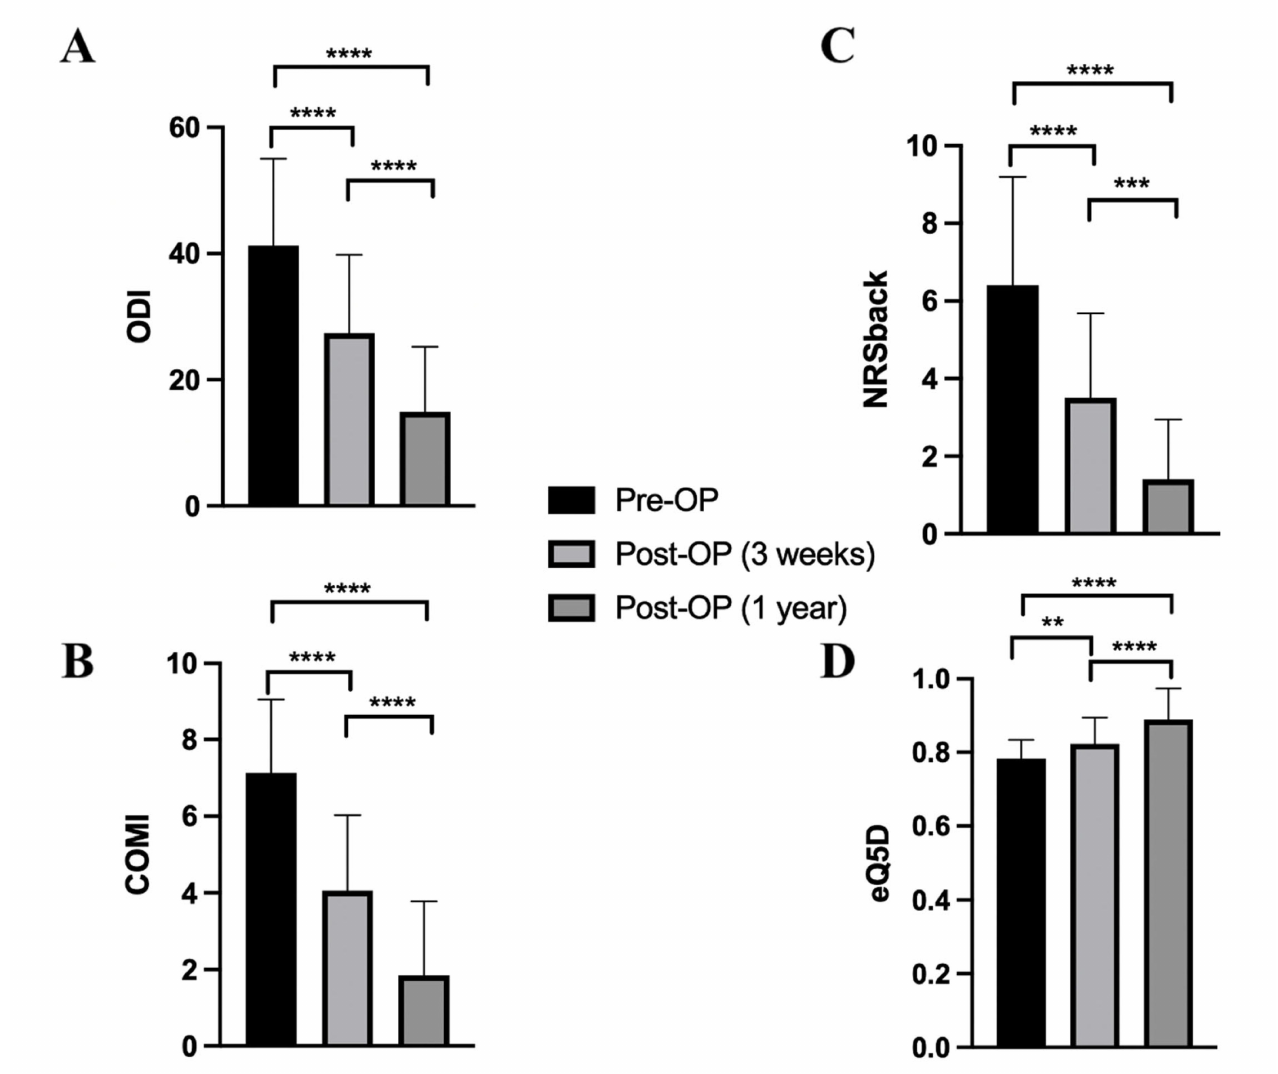
Figure 2. Bar charts show the ODI ( A ), COMI ( B ), NRS back ( C ), and eQ-5D ( D ) difference be- tween time points after thoracolumbar spine stabilization utilizing minimal-invasive percutaneous screw-rod stabilization. Pre-OP: preoperatively; Post-OP (3 weeks): 3 weeks postoperatively; Post- OP (1 year): 1 year postoperatively. Bar charts show the mean ± sd. ** p < 0.01, *** p < 0.001, **** p <